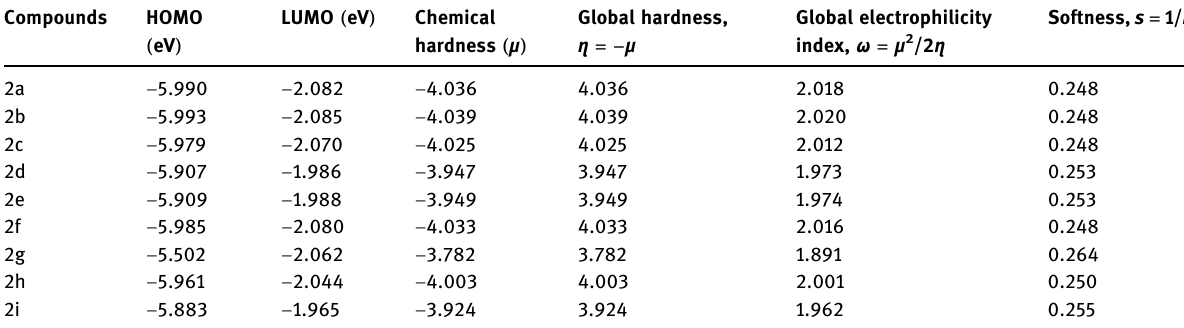
Table 3: Calculated energy and global descriptors